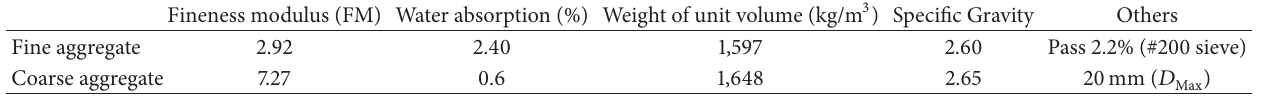
Table 2: Physical properties of sand and aggregate.